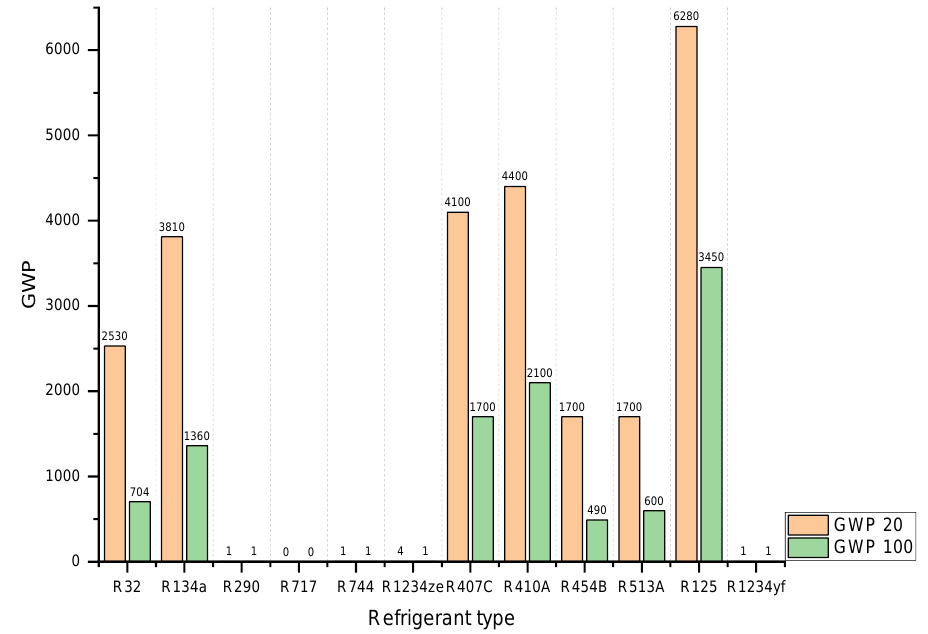
Figure 4. GWP 20 and GWP 100 index values for selected refrigerants and their components [29]. The CO 2 emission equivalent for each homogeneous refrigerant was calculated based on the formula: